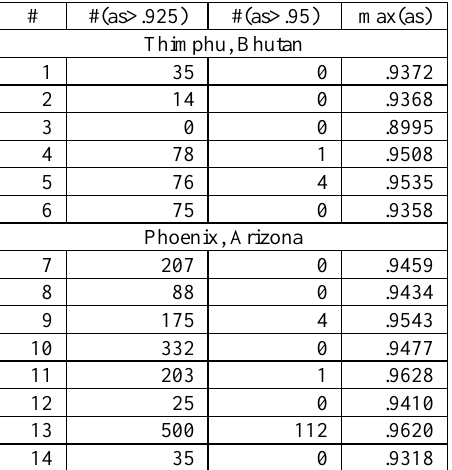
Table 3. Resulting numbers and properties of ∑|∑ -Gestalten